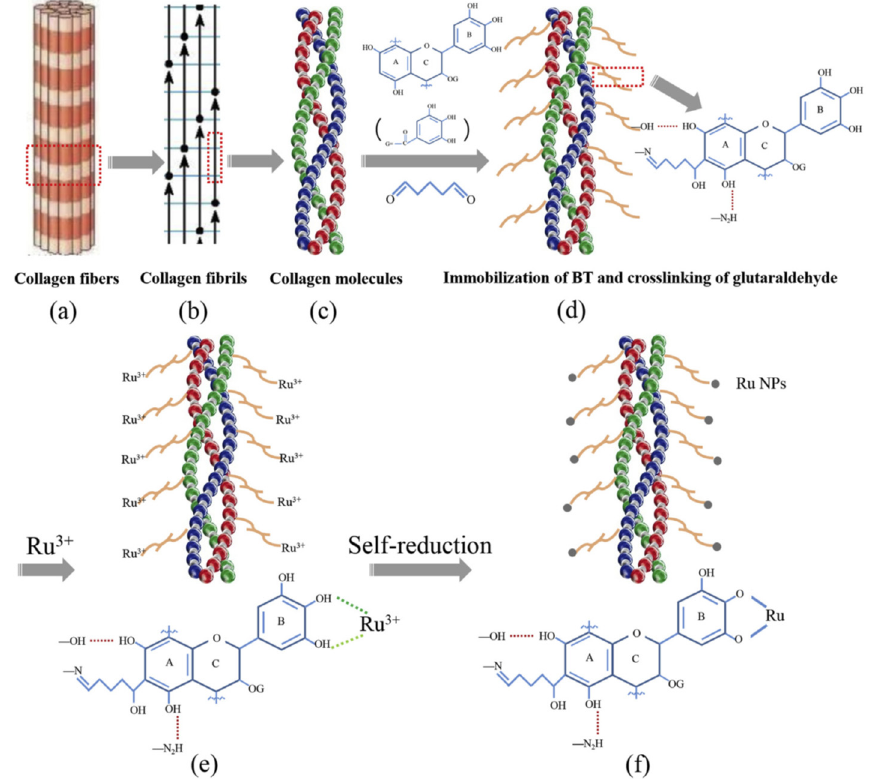
Figure 6. Diagram of ( a ) collagen fibers, ( b ) collagen fibrils, ( c ) collagen molecules, ( d ) immobilization of bayberry tannin (BT), and crosslinking of glutaraldehyde, ( e ) chelation of Ru 3+ ions with phenolic hydroxyl groups, and ( f ) formation of Ru NPs under self-reduction. Reprinted with permission from [71].